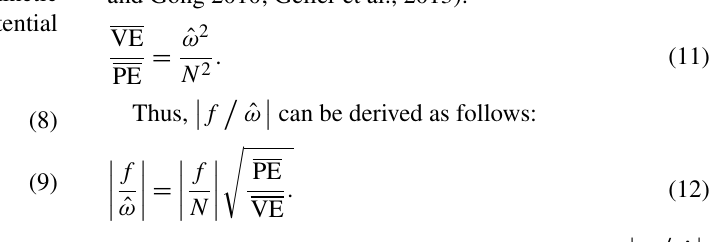
negative local maximum is present at heights of 50 to 55